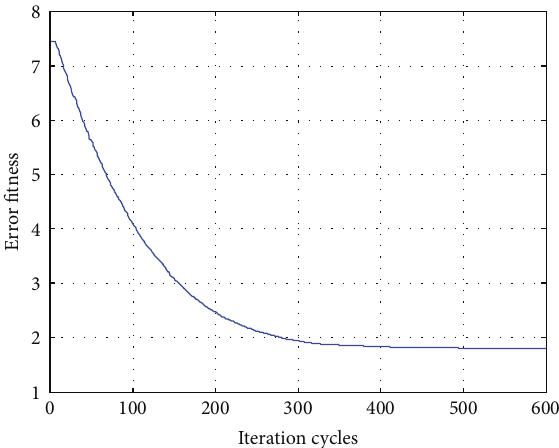
Figure 19: Convergence profile for DE in case of FIR HP filter of order 20.